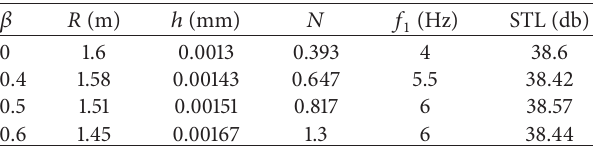
Table2:Effectof 𝛽 valuesonthedesignparametersoftheoptimized shell.